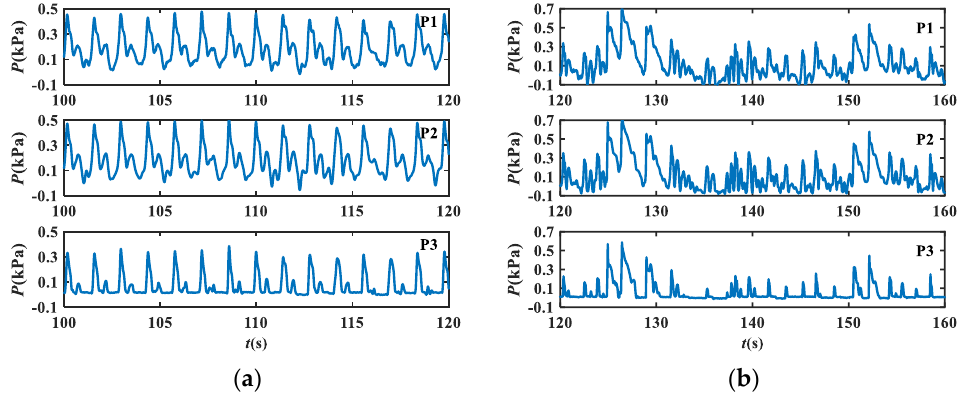
Figure 15. Time histories of wave pressure on the vertical seawall for the case of H 0 = 0.1 m, T 0 = 1.4 s, cot θ = 3, h r = 0.05 m: ( a ) regular wave; ( b ) irregular wave.